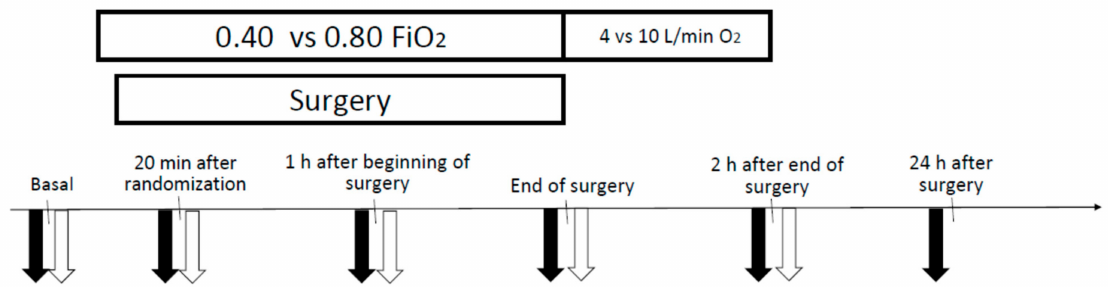
Figure 6. Experimental protocol. Clinical data and blood samples were collected, at the time points shown on the timeline, from patients undergoing abdominal surgery. After intubation, mechanically ventilated patients were randomized to receive FiO 2 0.40 versus 0.80 throughout the entire intraoperative period. After the extubation until 2 h after surgery, patients received oxygen at 4 (0.4 FiO 2 ) or 10 (0.80 FiO 2 ) L / min, respectively, through oxygen masks. Full arrows: arterial blood samples gathered for blood gas analysis. Empty arrows: venous blood samples gathered for oxidative stress